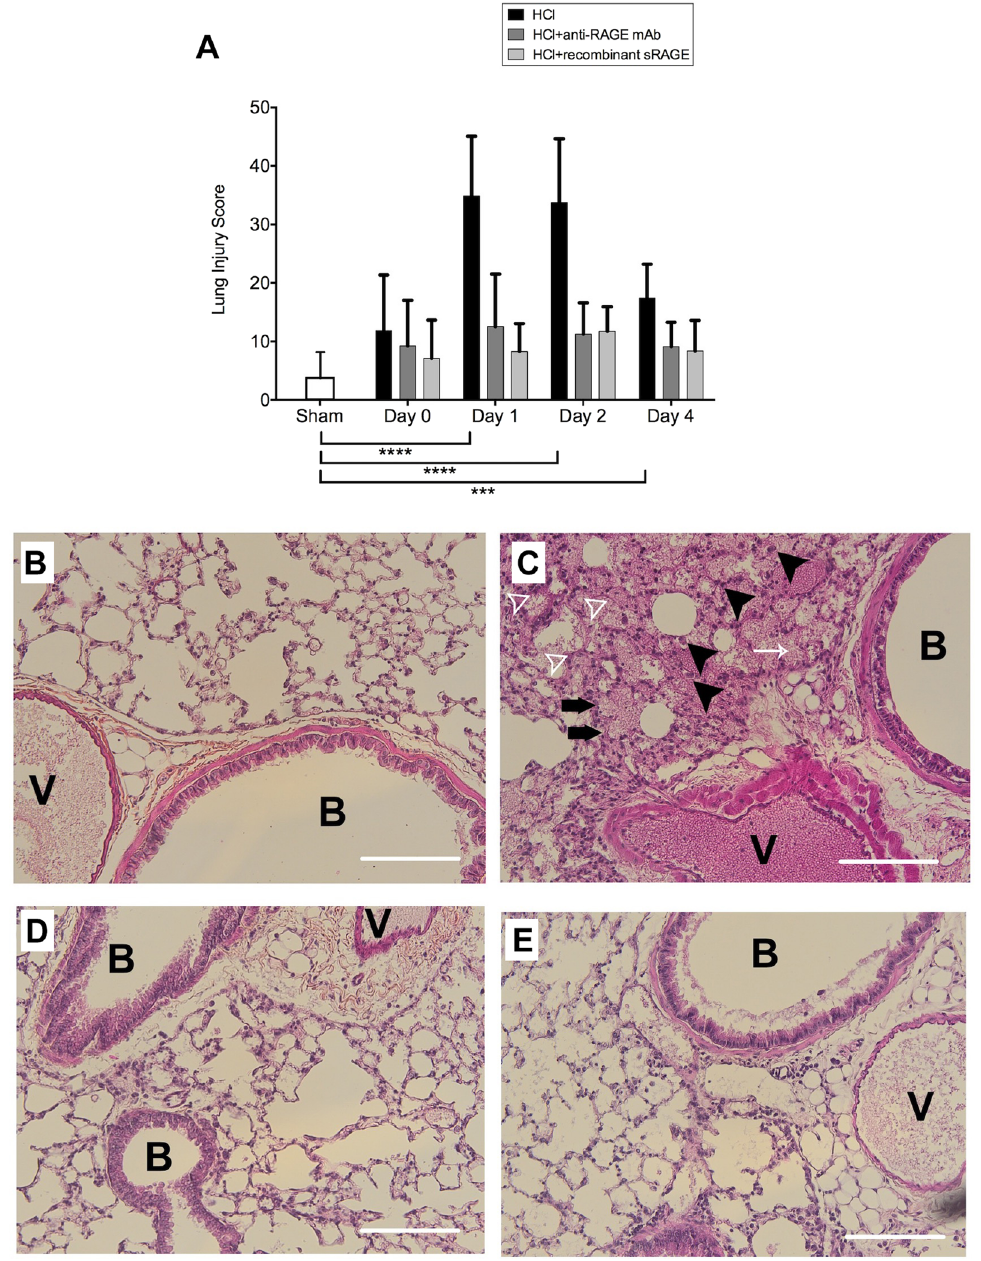
Figure 7. Histological features of lung injury. (A) On days 1, 2 and 4, lung injury scores were higher in acid- injured mice (HCl group), compared to sham controls (Sham group)(n = 4–6 for each time-point). In contrast, lung injury scores were lower in mice treated with anti-RAGE mAb (HCl + anti-RAGE mAb group) or sRAGE (HCl + recombinant sRAGE group) than in untreated acid-injured mice (HCl group) at all time-points, and similar to those in sham animals. Lung injury was assessed on a scale of 0–2 for each of the following criteria: i) neutrophils in the alveolar space, ii) neutrophils in the interstitial space, iii) number of hyaline membranes, iv) amount of proteinous debris, and v) extent of alveolar septal thickening. The final injury score was derived from the following calculation: Score = [20x(i) + 14x(ii) + 7x(iii) + 7x(iv) + 2x(v)]/(number of fields × 100). As no difference was observed between sham animals at all time points; the results from sham mice were mixed for analyses (left bar of the X-axis). Values are reported as means ± standard deviations. *** P < 10 − 3 ; **** P < 10 − 4 versus sham controls. (B – E) Representative hematoxylin and eosin stained sections of lung tissue, on day 2 after acid injury. (B) Sham controls (Sham group), (C) acid-injured animals (HCl group) and (D) acid-injured animals treated with anti-RAGE monoclonal antibody (HCl + anti-RAGE mAb group), (E) acid-injured animals treated with sRAGE (HCl + recombinant sRAGE group). There was greater cellularity consisting mainly of neutrophils (black arrowheads) on day 2 after injury, with more areas of atelectasis and increased alveolar disruption, hyaline membranes (white arrowheads), proteinous debris, haemorrhage (white arrow) and the thickening of the alveolar wall (black arrows). B: Bronchus lumen, V: Vessel . Original magnification × 20. Scale bars 50 μ